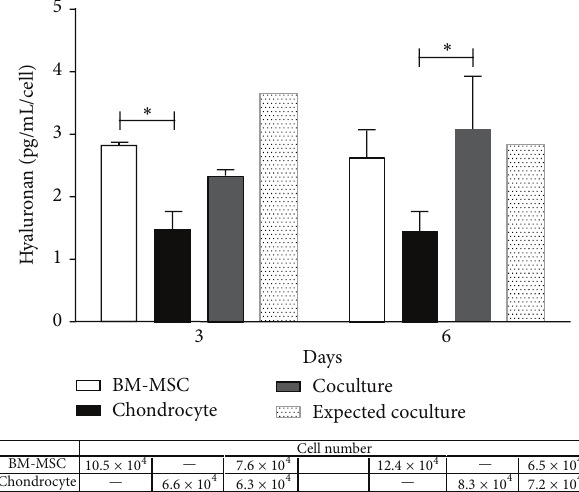
Figure 2: Coculture upregulates hyaluronan production. Hyaluro- nan concentration (pg/mL/cell) after 3 and 6 days in monoculture (BM-MSCs and chondrocytes) or in coculture. Bars represent the mean and SEM; bars with gray line (expected coculture) show “expected hyaluronan production in coculture,” based on produc- tion of monoculture and cell number counted. Table shows the cell number in each group. The asterisk ( ∗ ) indicates a significant ( 𝑃 ≤ 0.05 ) difference between cell culture groups based on a two- way ANOVA followed by Tukey’s